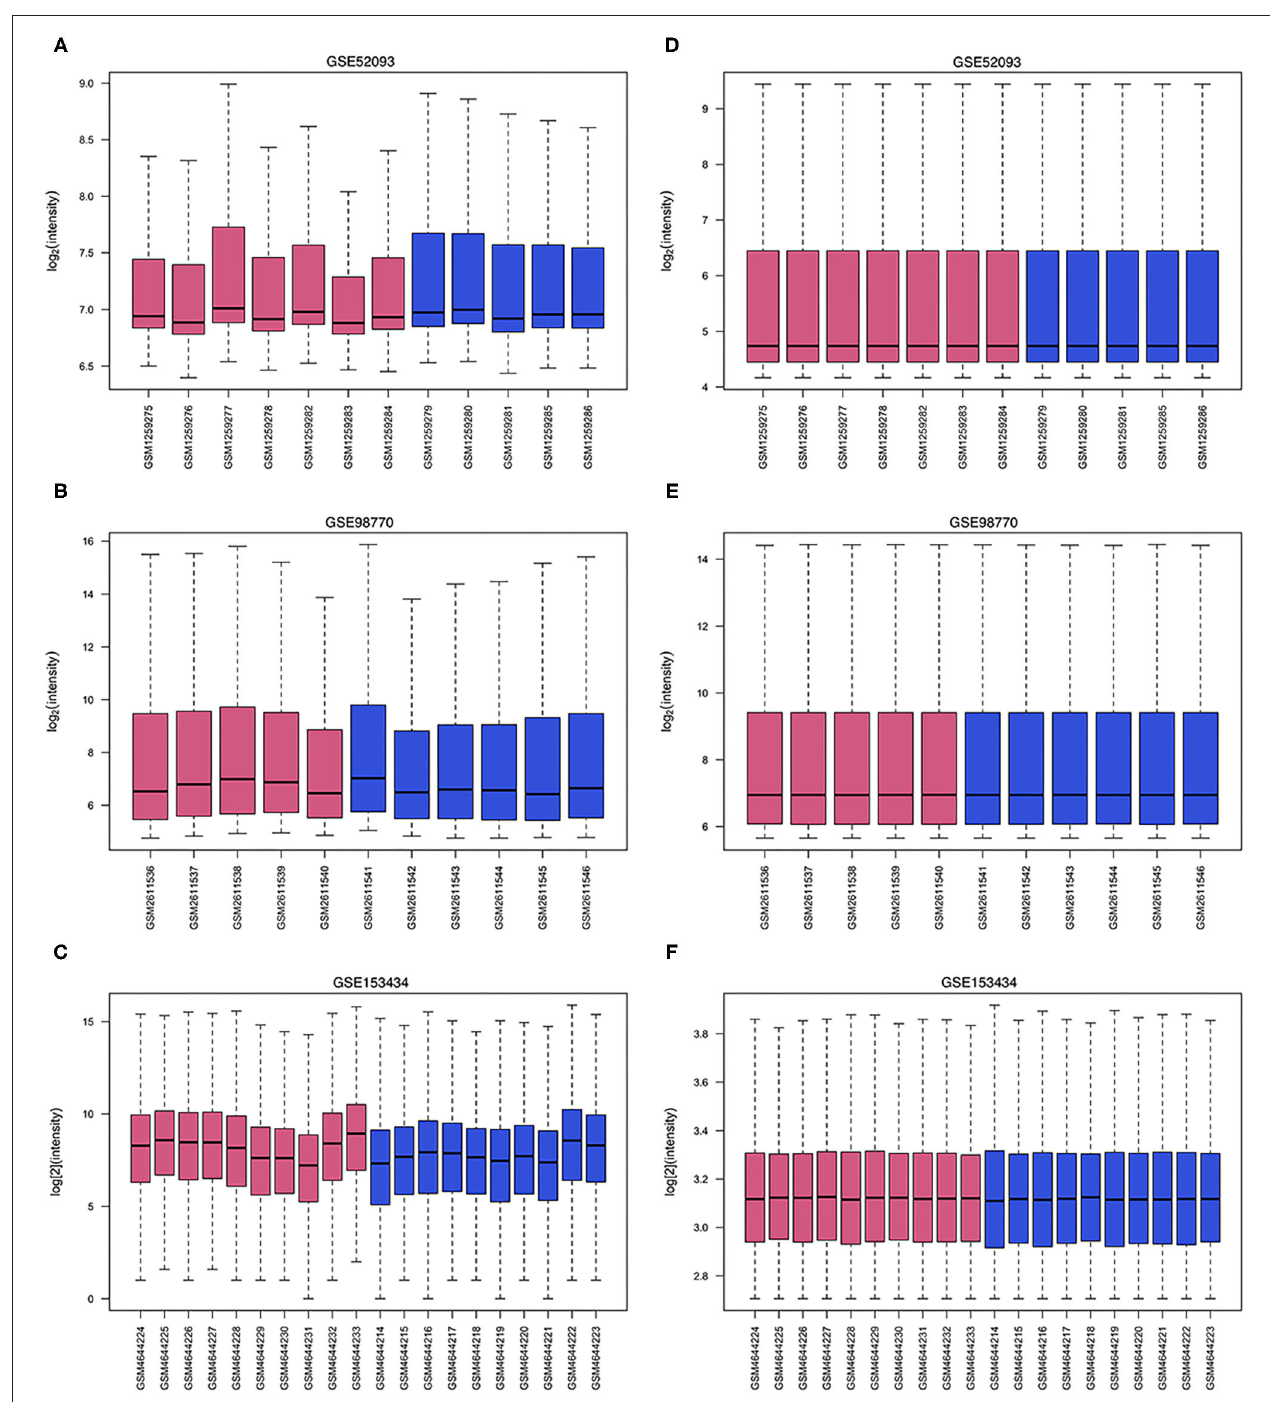
FIGURE 1 | Data processing of gene expression profiles. The red bars represent data from AAD patients, and the blue bars represent data from non-AAD patients. (A–C) Raw data of GSE52093, GSE98770 and GSE153434. (D–F) Normalized data of GSE52093, GSE98770, and GSE153434.